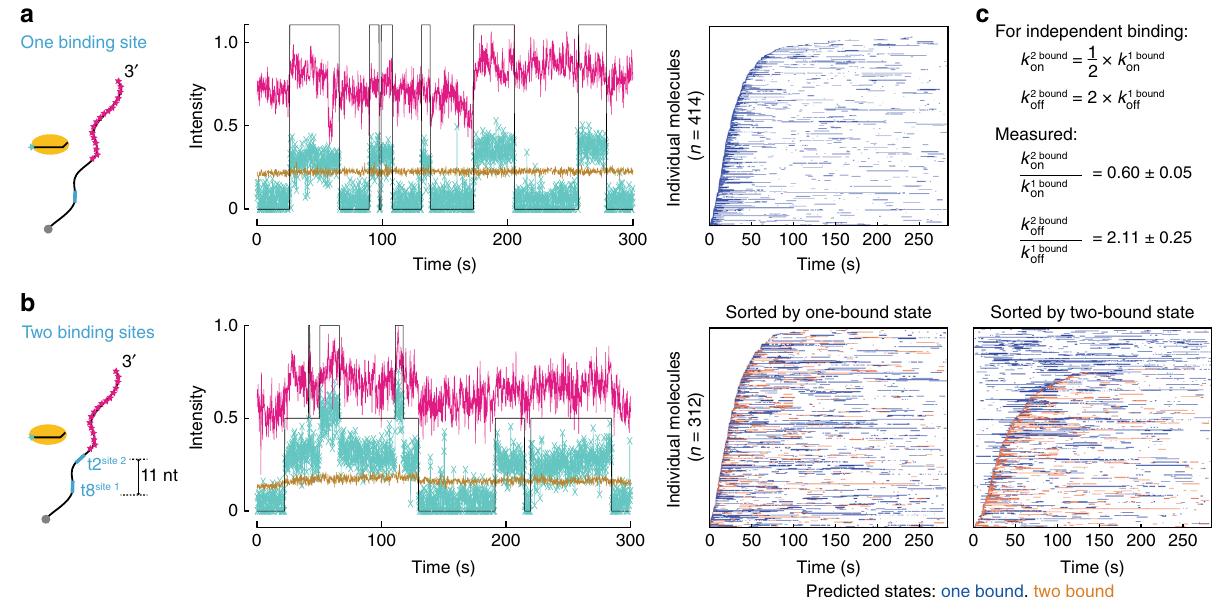
Fig. 2 DNA-guided TtAgo binds independently to DNA targets containing two adjacent seed-matched t1G sites. Representative fl uorescence intensity time traces of TtAgo (turquoise) binding DNA target (magenta) containing one binding site ( a ) or two binding sites spaced 11 nt apart from t8 to t2 ( b ). Light brown indicates background levels of green fl uorescence, whereas the black line denotes binding events detected by the pipeline after VBEM-MGHMM analysis. Fluorescence intensity is expressed in thousands of photons. Representative rastergrams summarize traces of individual target molecules, each in a single row and sorted according to their arrival time. c Comparison of k on and k off of DNA-guided TtAgo with targets containing one or two binding site(s). Values are reported as mean ± standard deviation for three independent